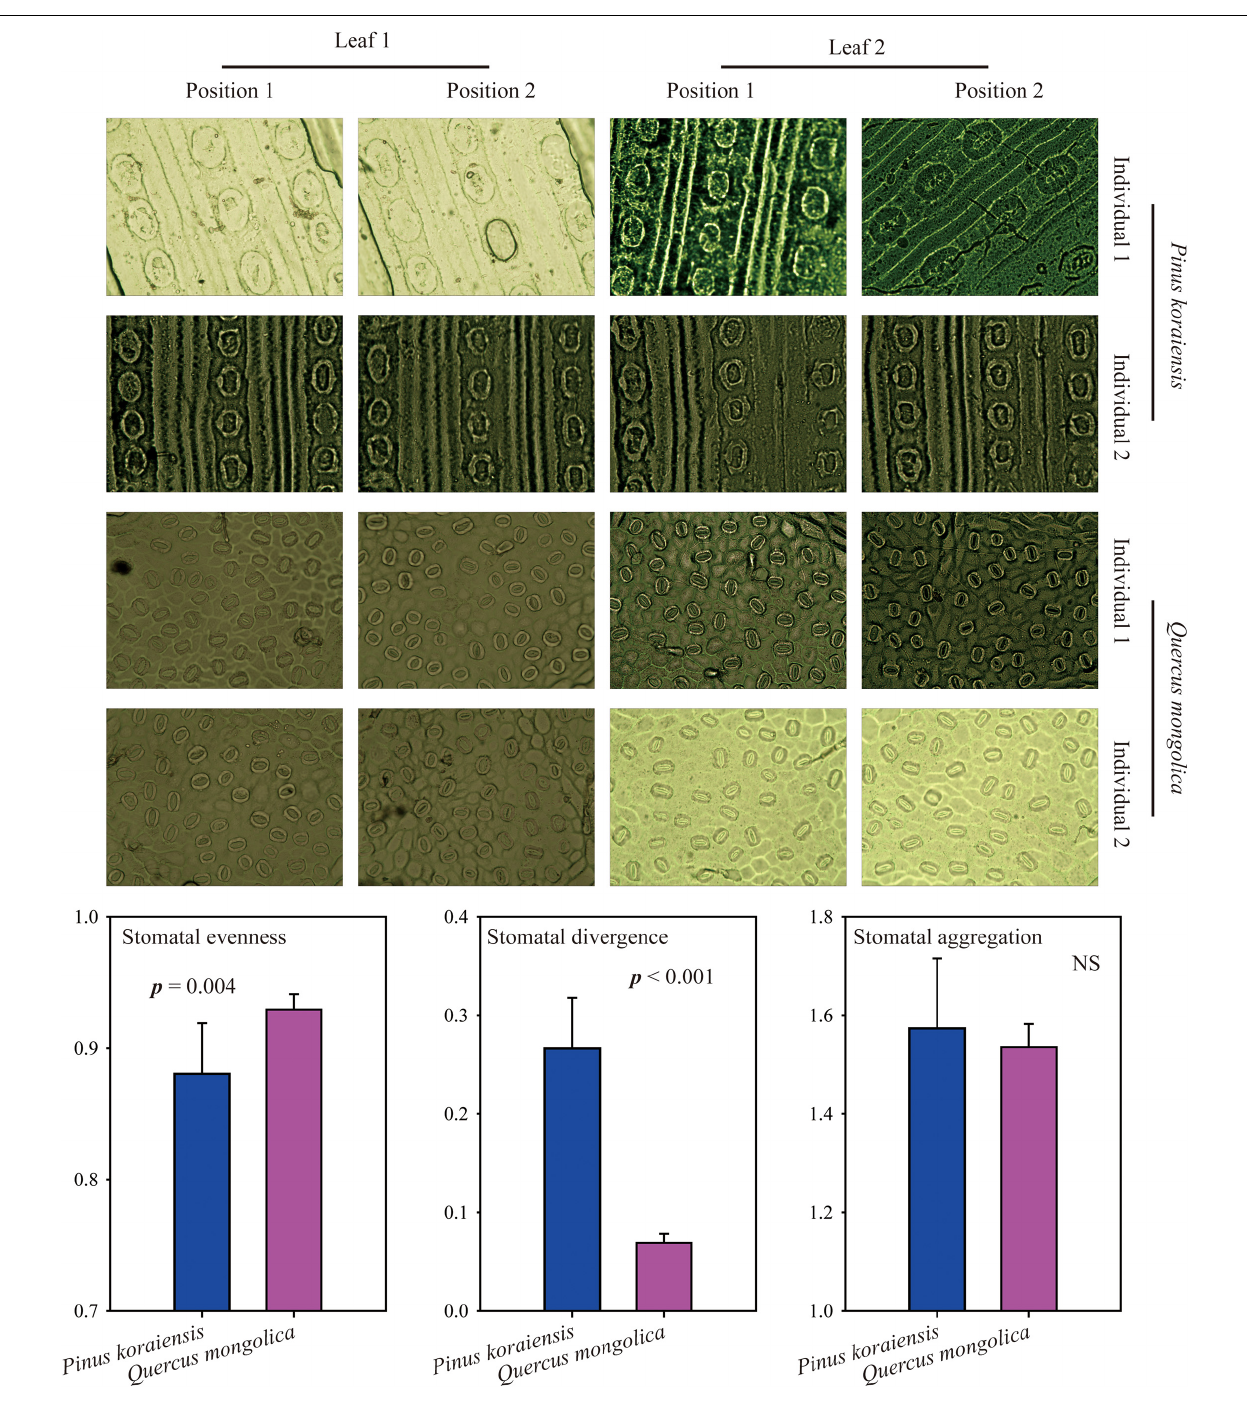
Frontiers in Plant Science |